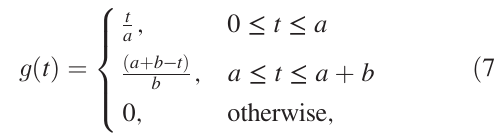
FIG. 5. Photoemitted extracted charge of the Cu, ND H-ND-based cathodes and the Child-Langmuir (C-L) red curve as a function of the accelerating